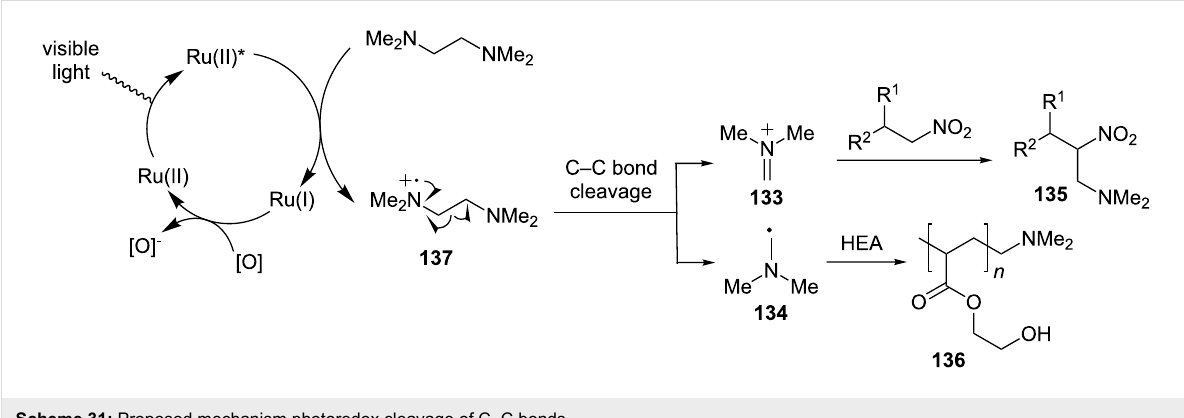
Scheme 31: Proposed mechanism photoredox cleavage of C–C